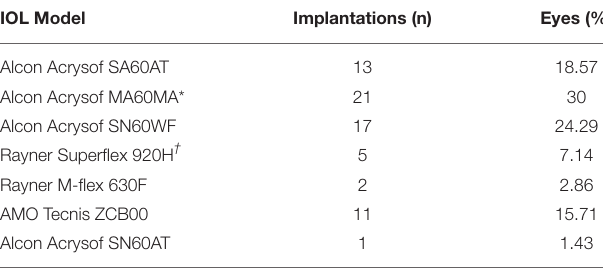
TABLE 2 | Intraocular lens implantations by IOL model ( n = 70).